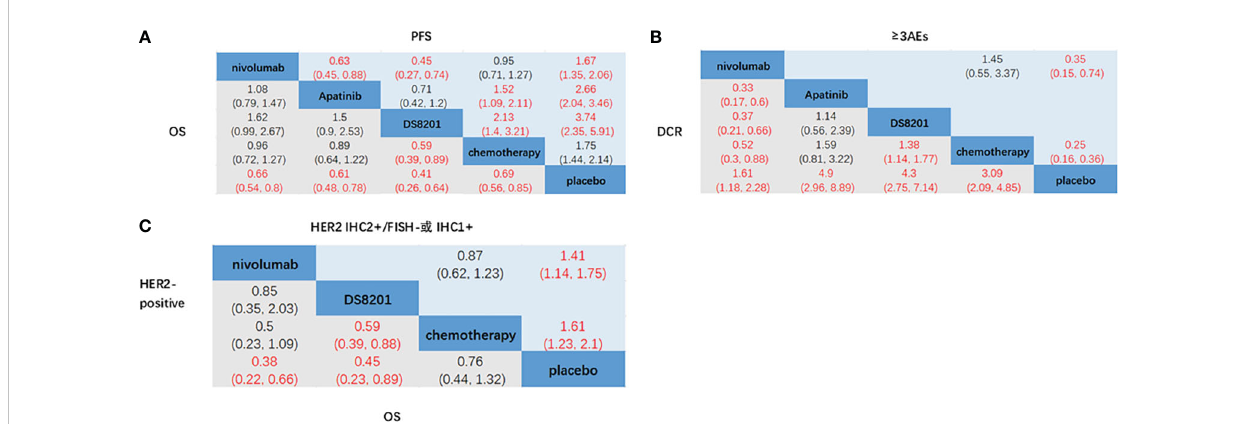
FIGURE 3 Network meta-analysis of the third-line treatments for advanced GC/GEJC. (A) Pooled hazard ratio (HR) [95% CrIs (credible intervals)] for overall survival (OS) and progression-free survival (PFS) in the overall population. (B) Pooled relative risk (RR) (95% CrIs) for disease control rate (DCR) and adverse events of grade 3 or higher ( ≥ 3AEs) in the overall population. (C) Pooled HR (95% CrI) for OS of patients with HER2-positive and HER2 IHC2 +/FISH- or